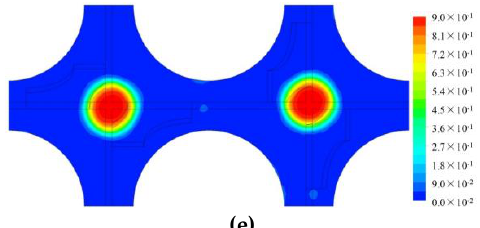
Figure 5. Vapor fraction at downstream of vaned spacer for case 4: ( a ) L = 0.01 m, ( b ) L = 0.05 m, ( c ) L = 0.08 m, ( d ) L = 0.10 m, ( e ) L = 0.15 m.